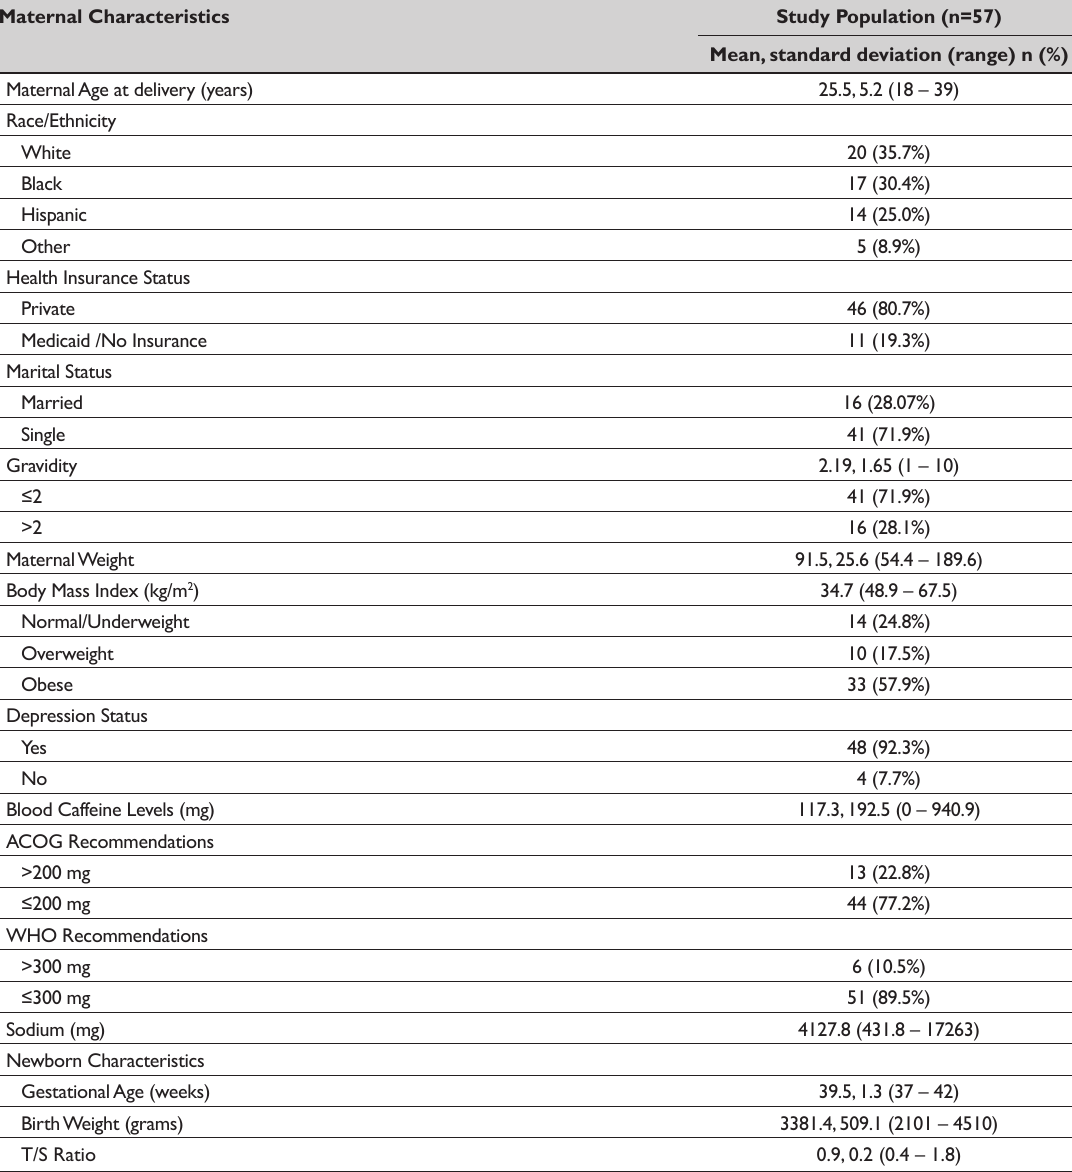
Table 1: Demographic and developmental characteristics of mother and newborn at time of delivery (n = 57 maternal-newborn pairs) Maternal